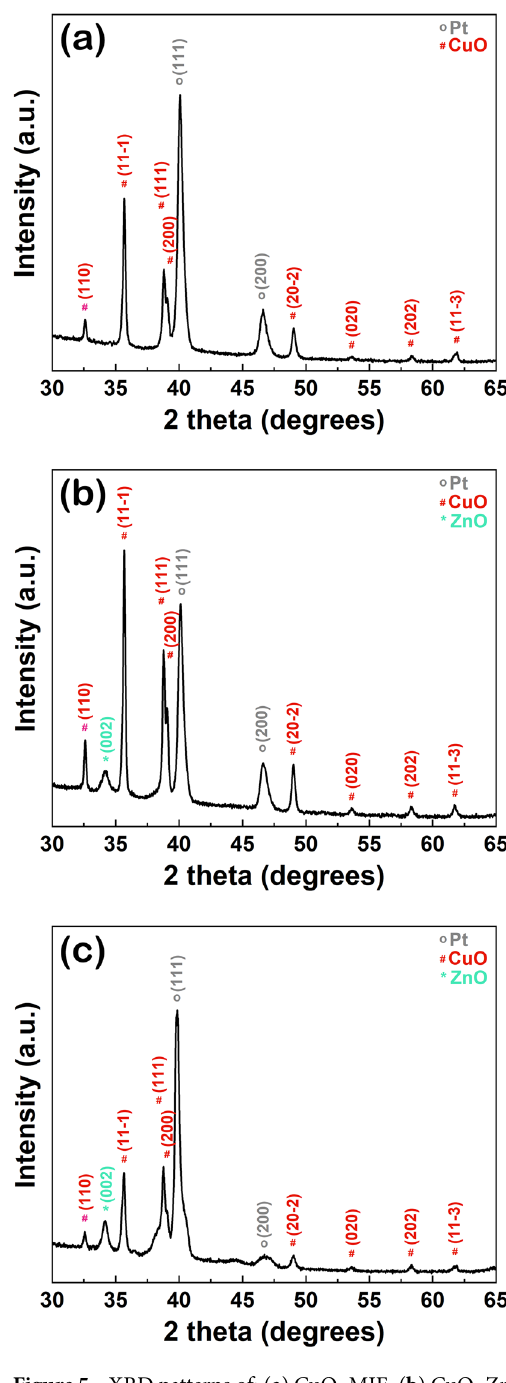
Figure 5. XRD patterns of: ( a ) CuO_MIE, ( b ) CuO–ZnO_MIE_1 and ( c )